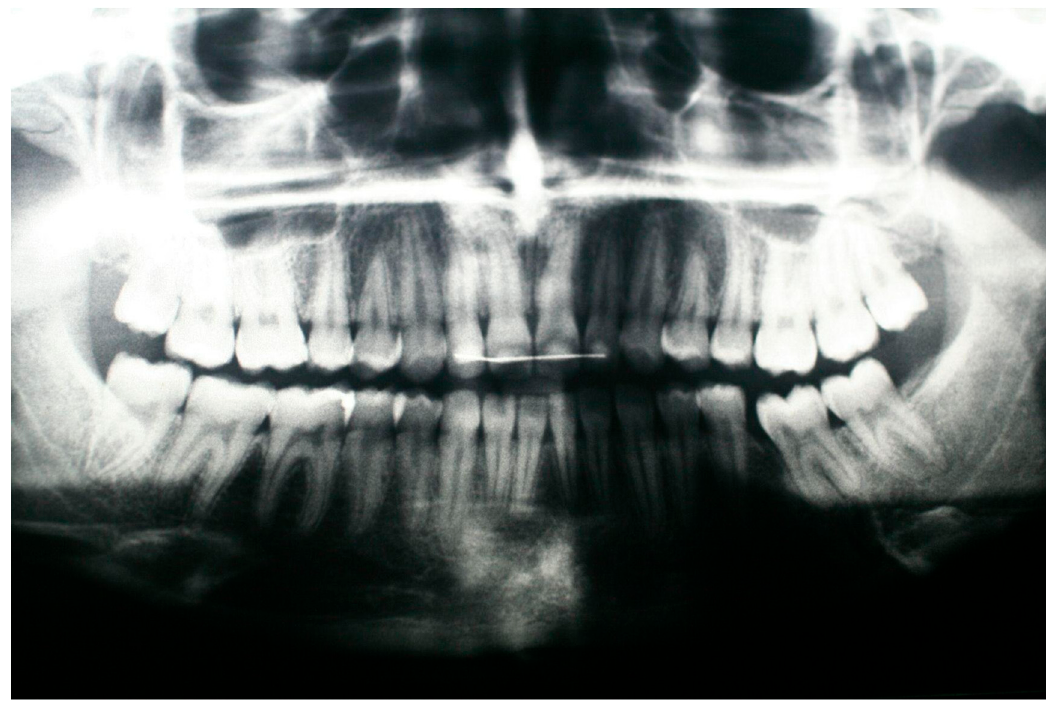
Figure 7. Panoramic radiograph 14 months after the debonding of the fixed orthodontic appliances and 32 months after the marsupialization of the dentigerous cyst.